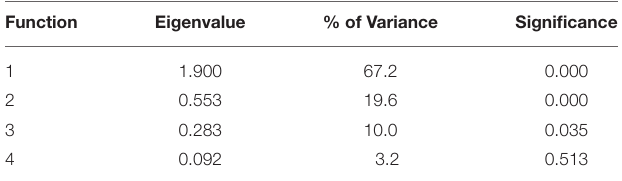
TABLE 3 | Criteria to evaluate discrimant functions of biological parameters.